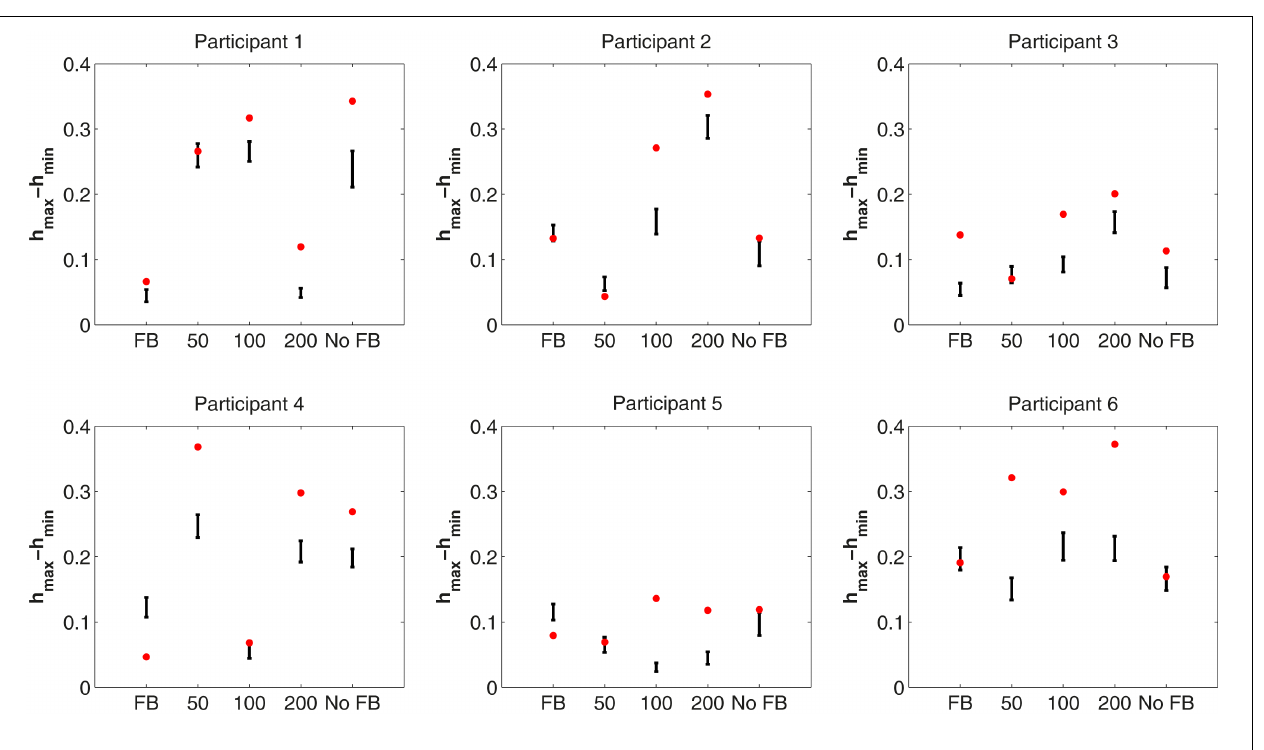
confidence interval for the 30 surrogate time series from each response series is illustrated. Multifractal spectrum width for a pure simulated 1/ f noise without phase couplings is close to